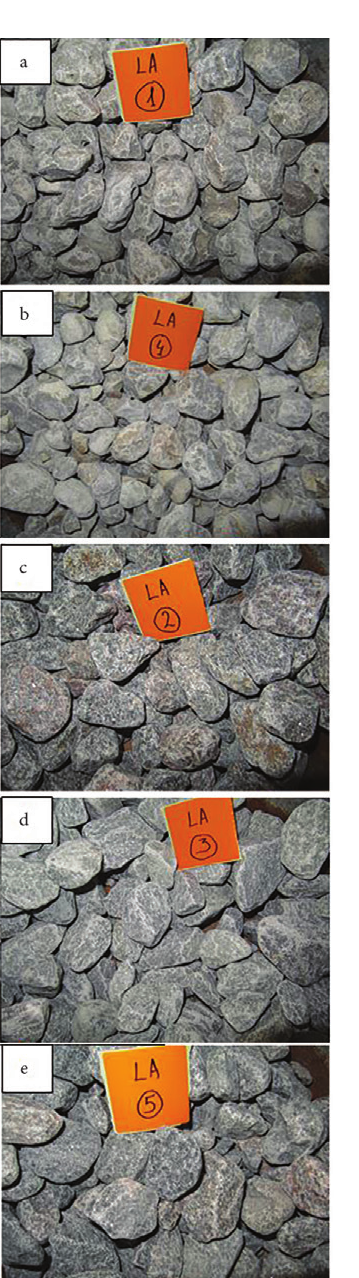
Fig. 2. The dried samples after the Micro-Deval Abrasion test (Figure parts a, b, c, d, e provide the D1, D2, G1, G2, G3